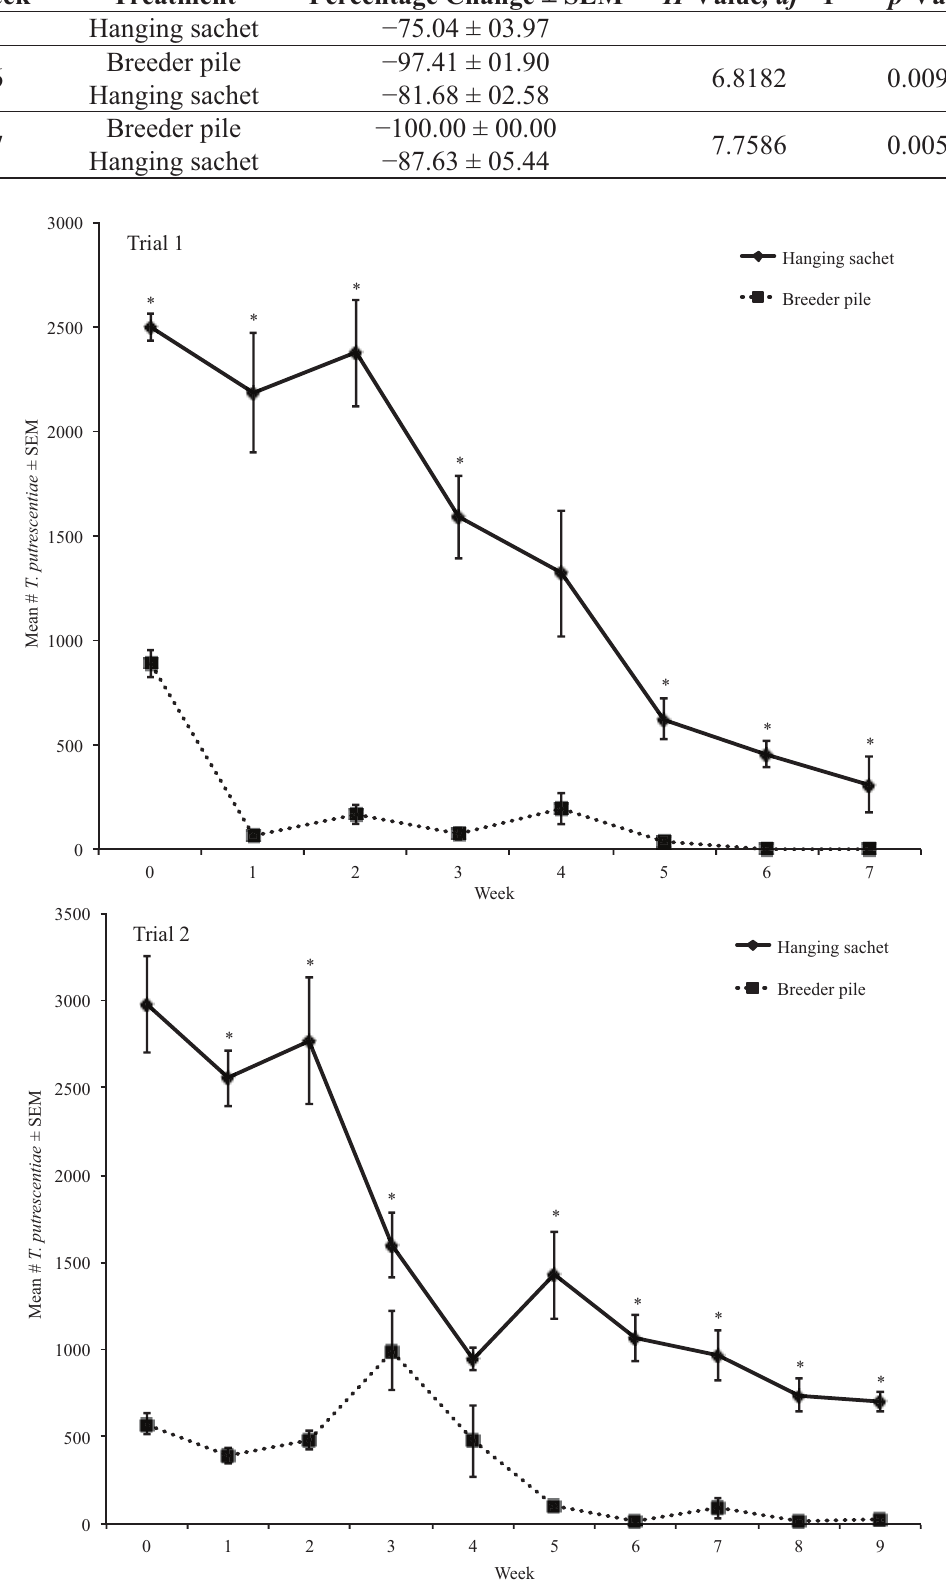
Figure 3. Mean number of T. putrescentiae extracted from treatments in trials 1 and 2. * Means are significantly different among treatments in the same sampling period (Kruskal- Wallis, α =